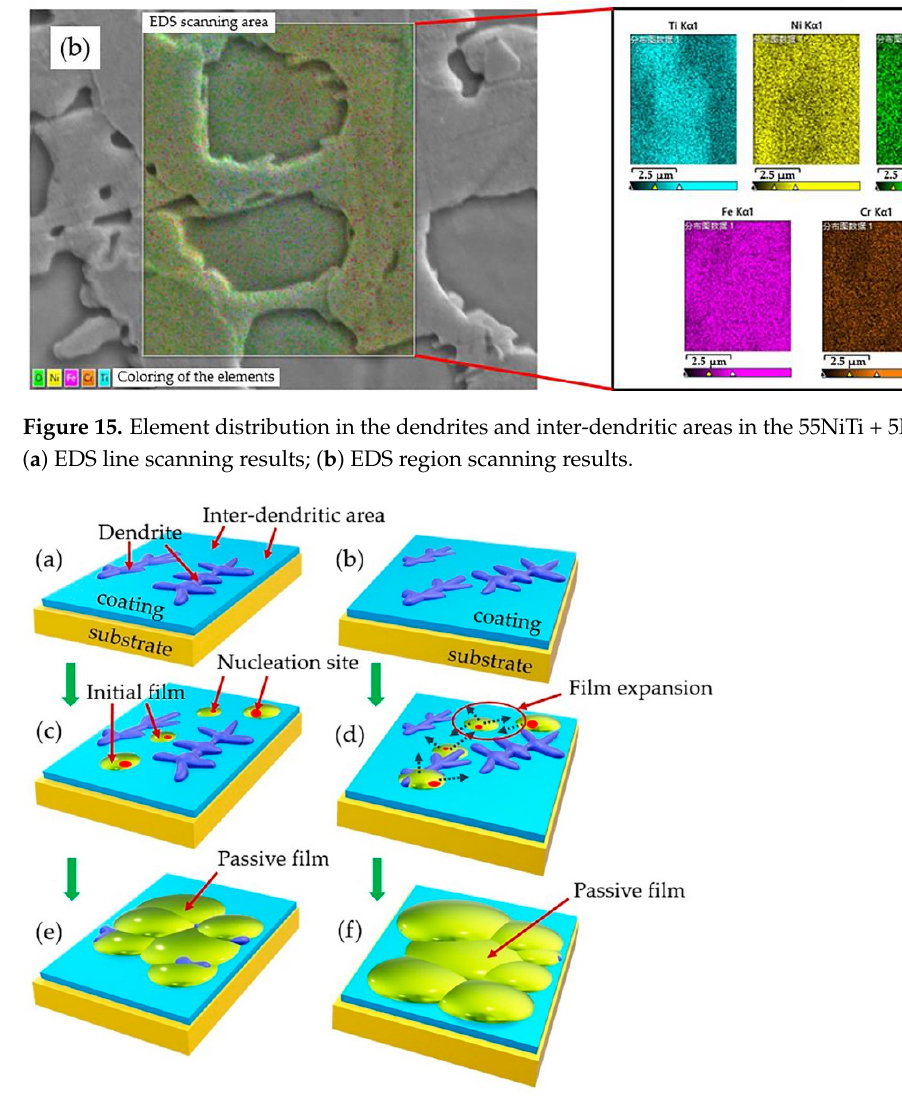
Figure 16. Schematic illustration of the passive film initiation and expansion process: ( a , c , e ) 55NiTi coating; ( b , d , f ) 55NiTi + 5Ni coating.